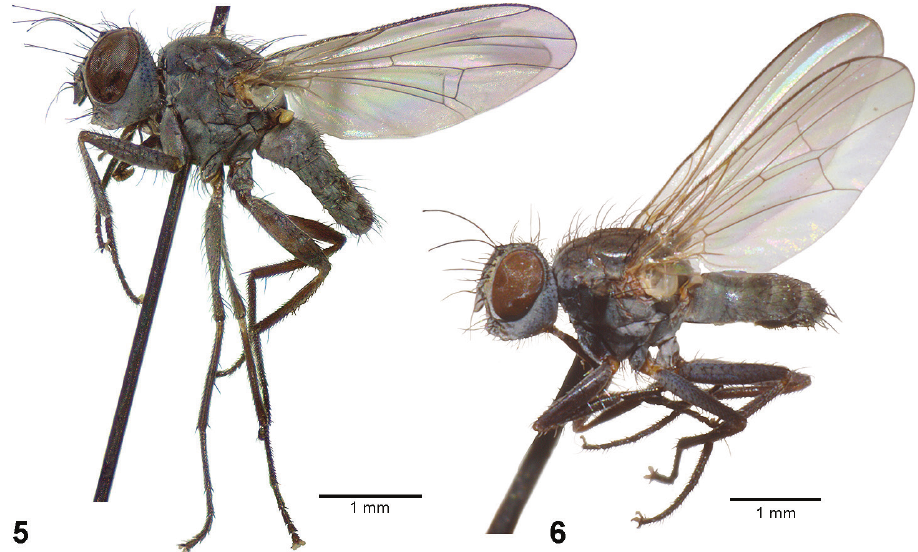
Figures 5, 6. Coenosia spp. habitus, lateral view 5 C. macrotriseta ♂ 6 C. globuliseta ♂ . Figs 5, 6 reused (Muller and Miller 2013, figs 1A,